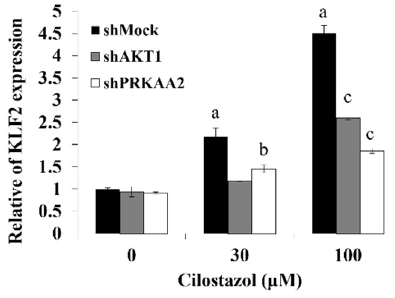
Figure A1. Cilostazol upregulates KLF2 partially through PRKAA2 or AKT1 pathways. The HUVECs were transfected with shRNA, which blocked AKT1 or PRKAA2 expression. shMock was used as the vector control. After transfection, cells were cultured with 0, 30, and 100 µ M cilostazol for 24 h. Then, cells were collected, and KLF2 mRNA expression was assessed using quantitative real-time PCR. Data are expressed as mean ± SEM, n = 3. a, p < 0.05 compared to shMock 0 µ M cilostazol; b, p < 0.05 compared to shMock 30 µ M cilostazol; c, p < 0.05 compared to shMock 100 µ M cilostazol.